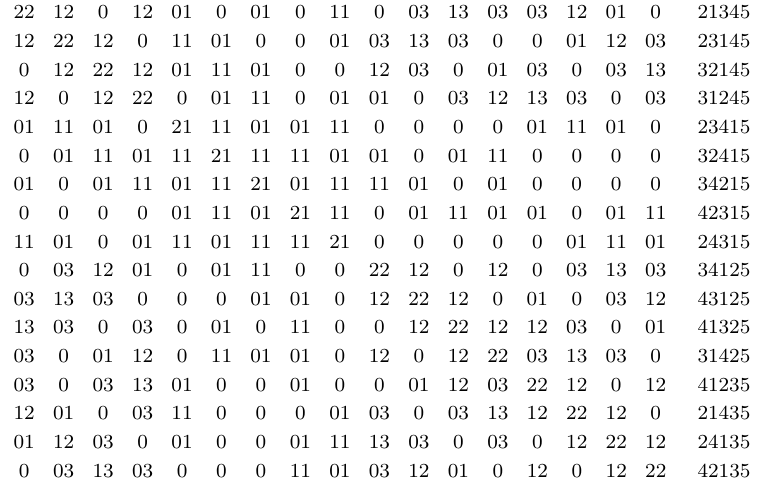
Table 2 . Representation of the TMD-valued color matrix and vector of partial amplitudes for the processes g (cid:3) q 4 ! g 2 g 3 q 5 . Each pair ij of intergers represents N i 1 the entry vanishes. The last column gives the permutation associated with the partial